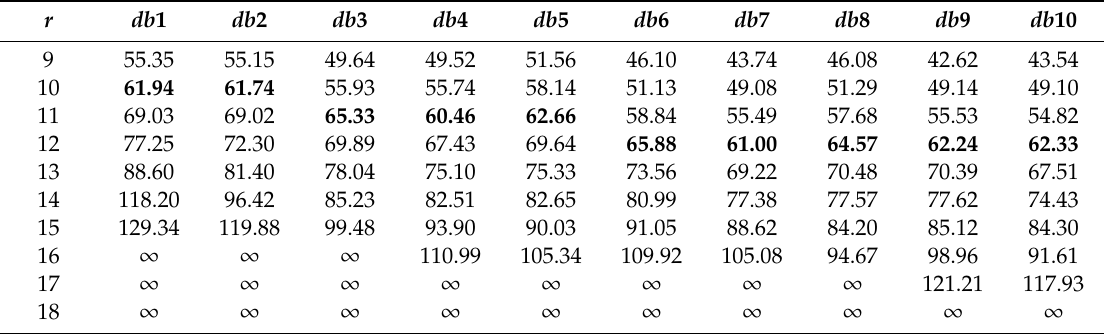
Table 15. Experimental results ( PSNR , dB) of 3D tomographic 12-bit image “Trufi_COR” DWT by using bit-width r of Daubechies wavelets filters coe ffi